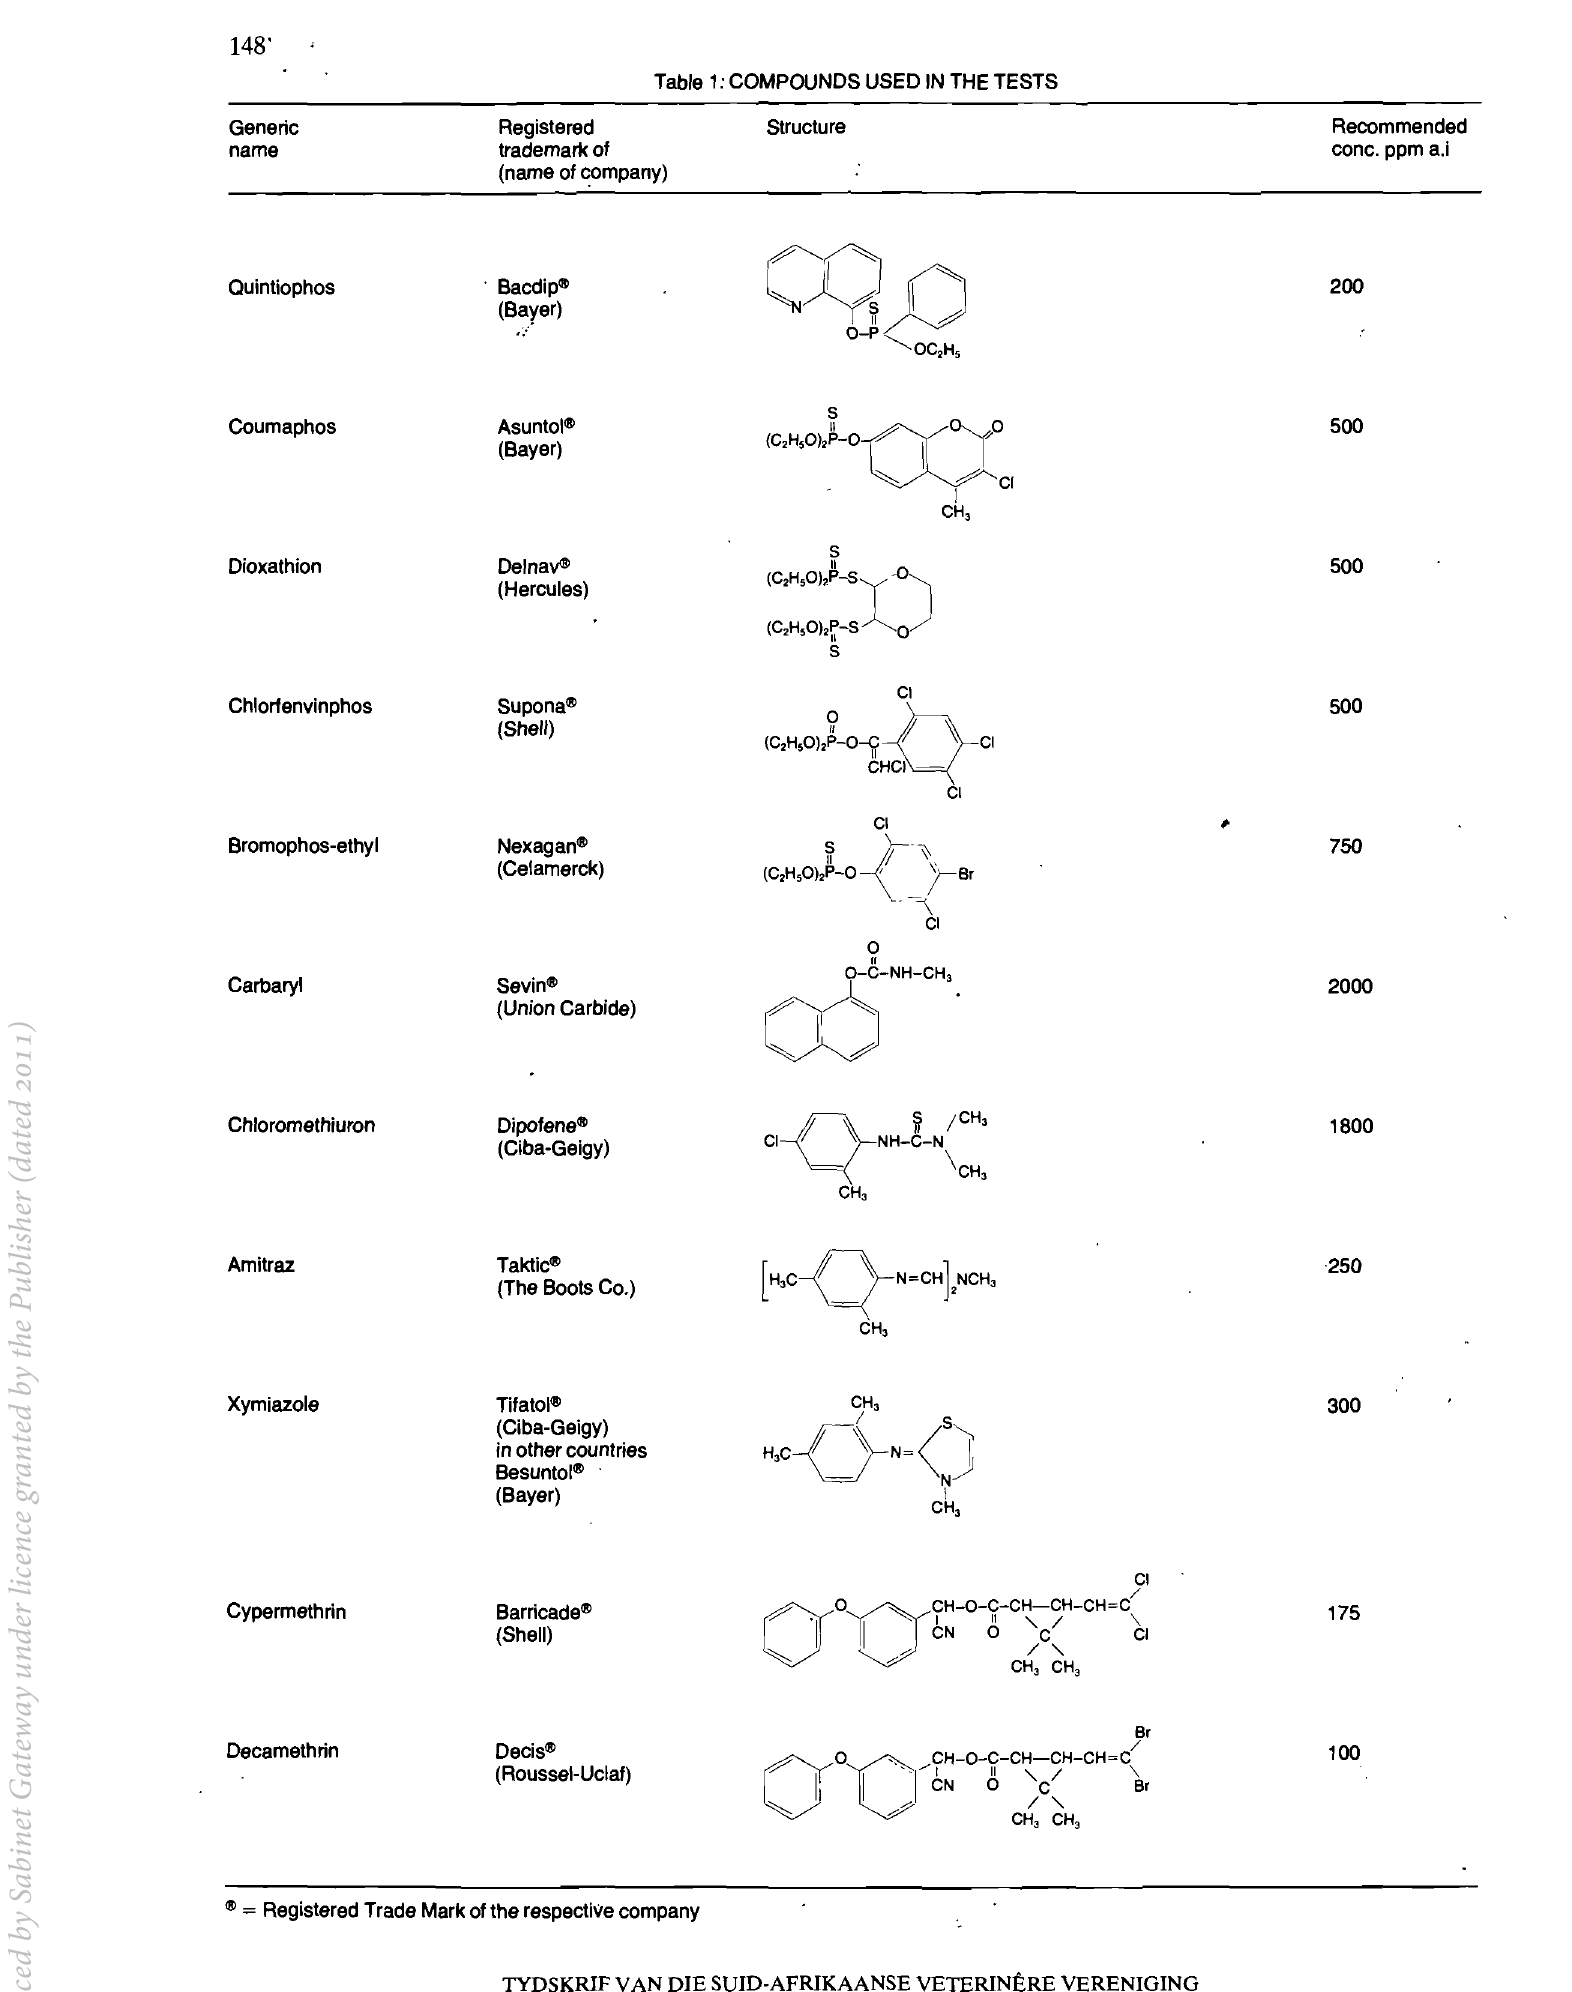
Table 1: COMPOUNDS USED IN THE